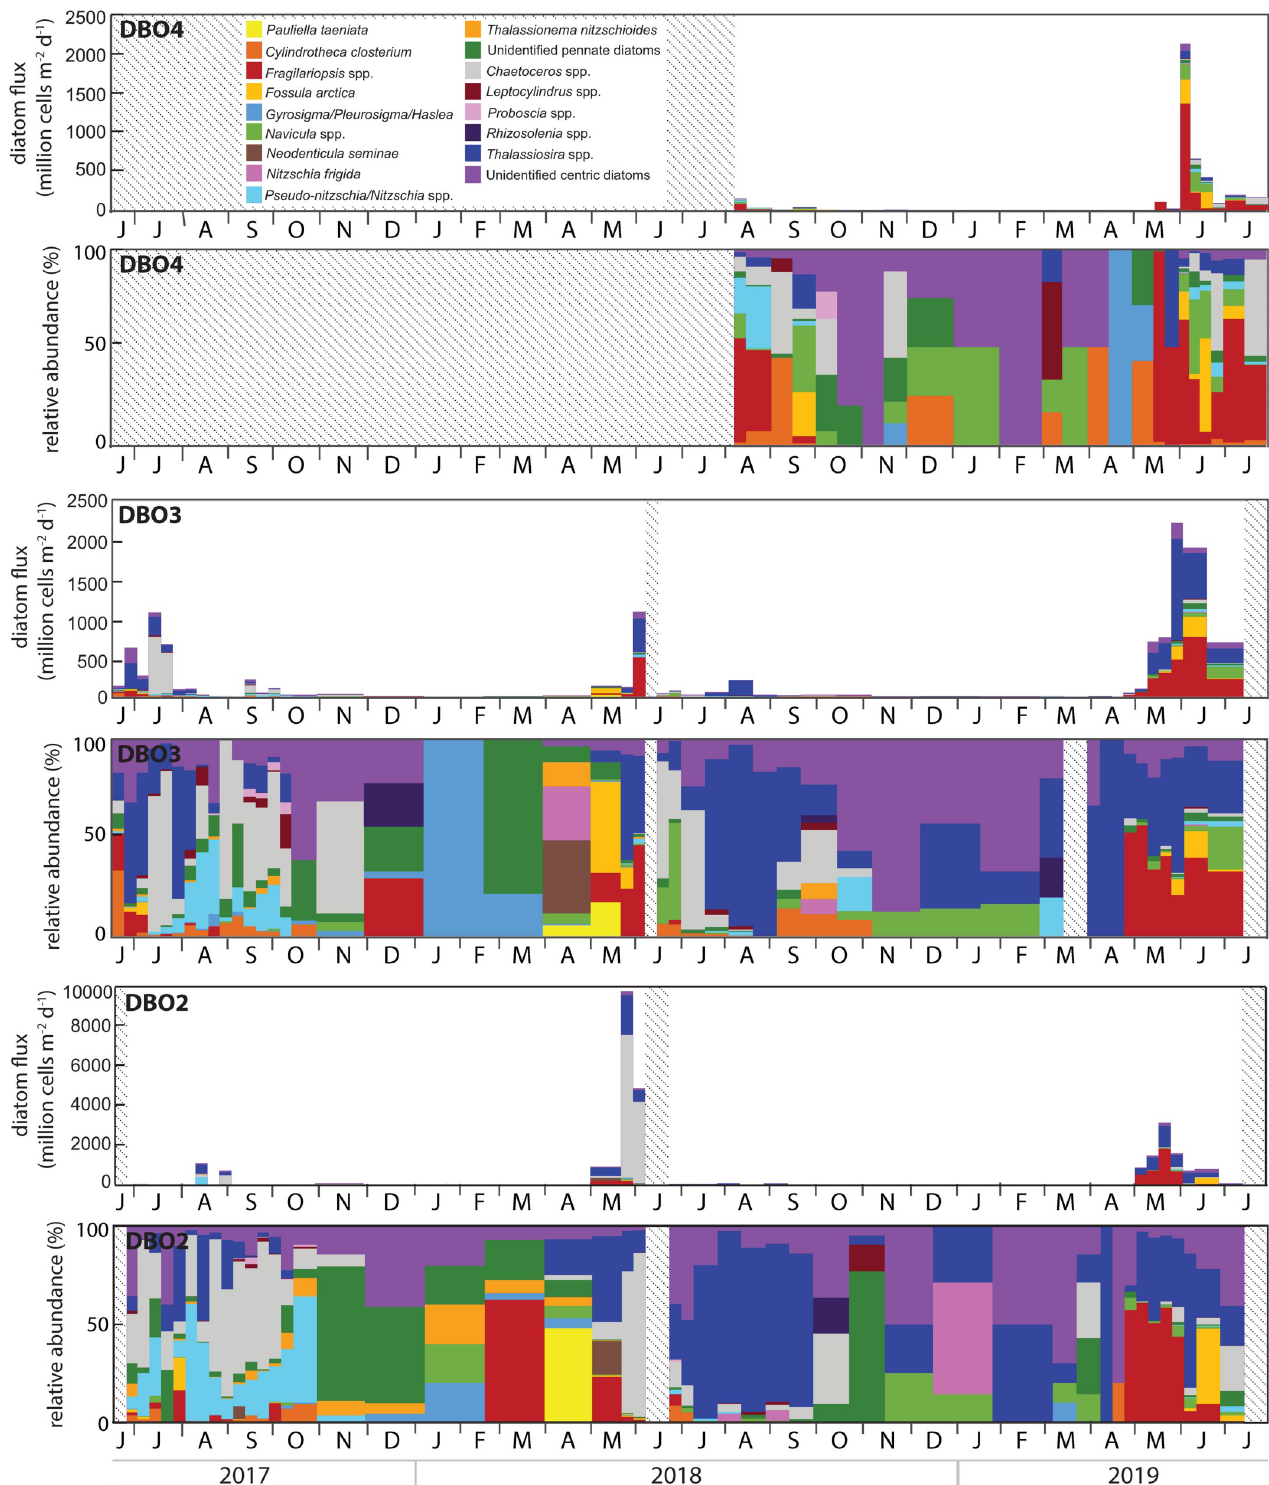
Fig 5. Diatom fluxes and relative abundance of the dominant diatom groups at each mooring site. Note the different scales. Shaded areas represent periods without data.